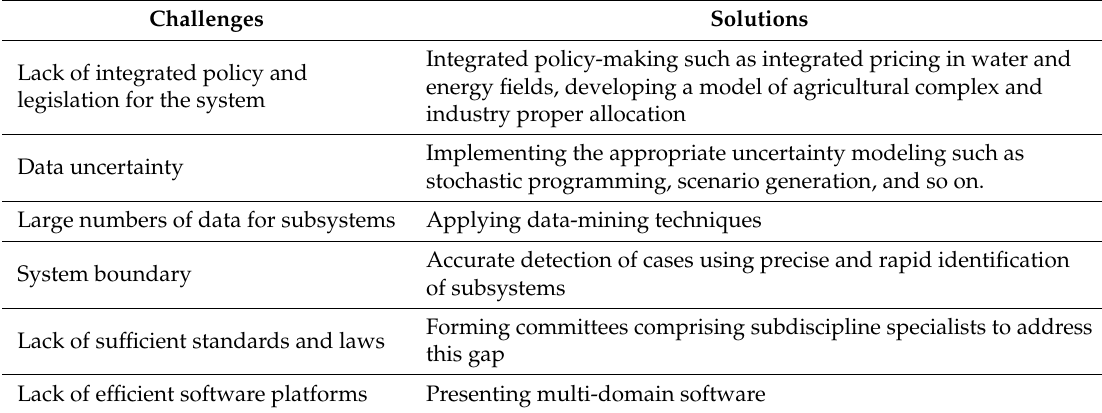
Table 5. Some of the challenges and solutions for implementing nexus